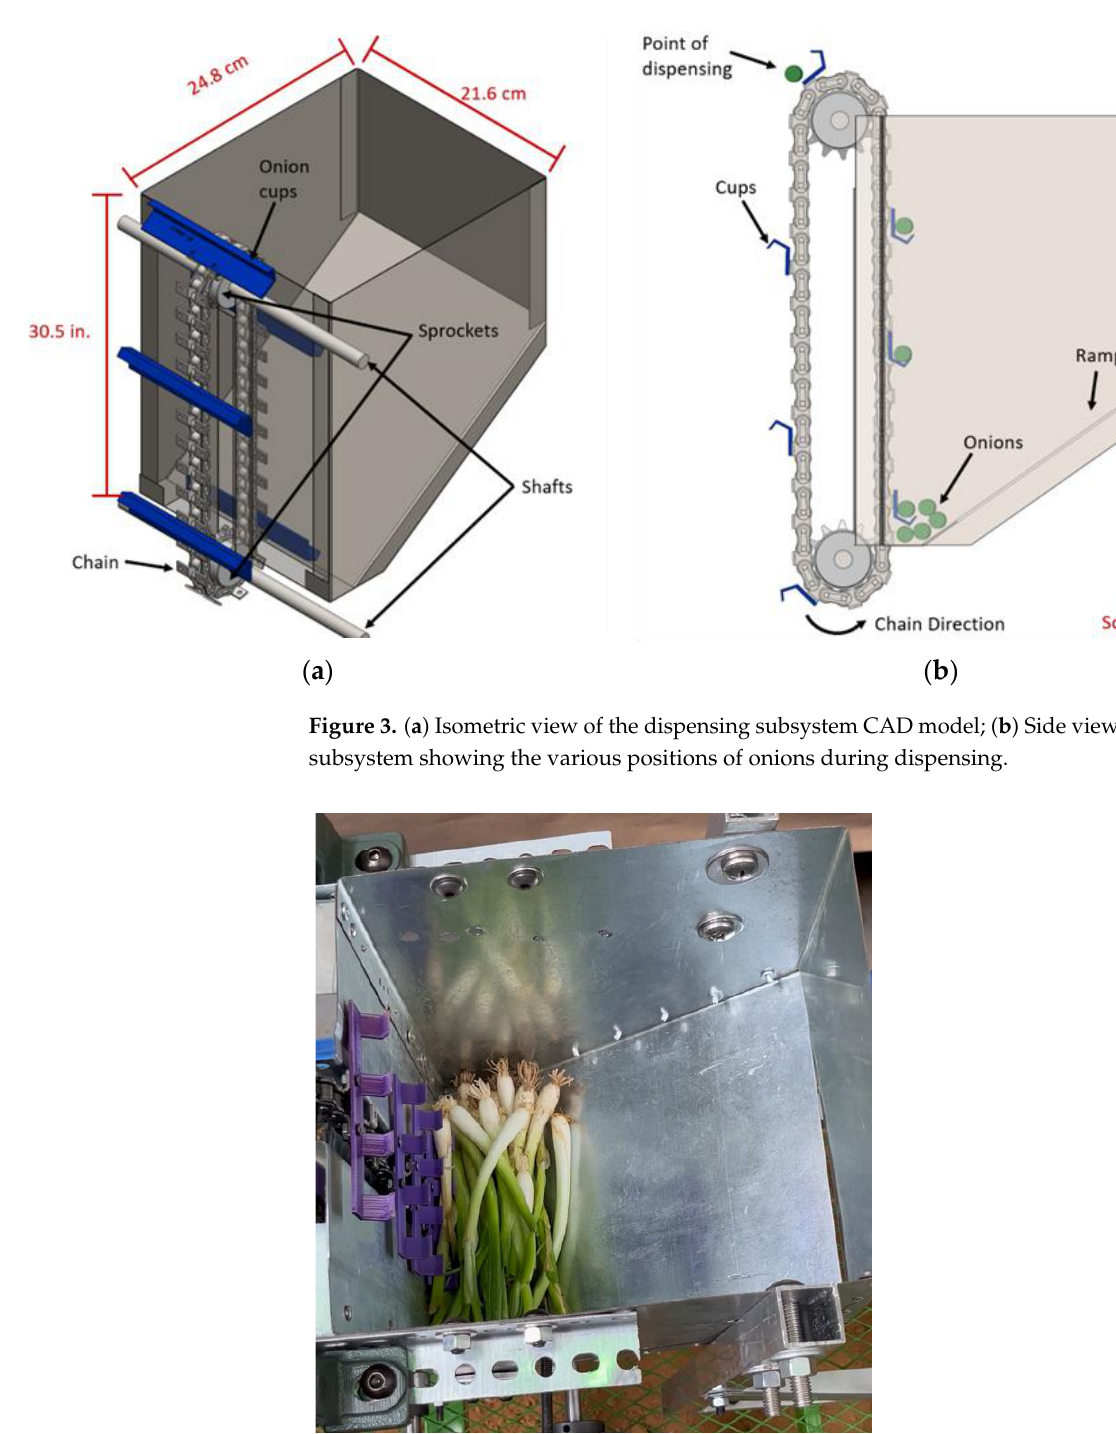
Figure 4. Uniformly oriented onions in the dispensing subsystem.